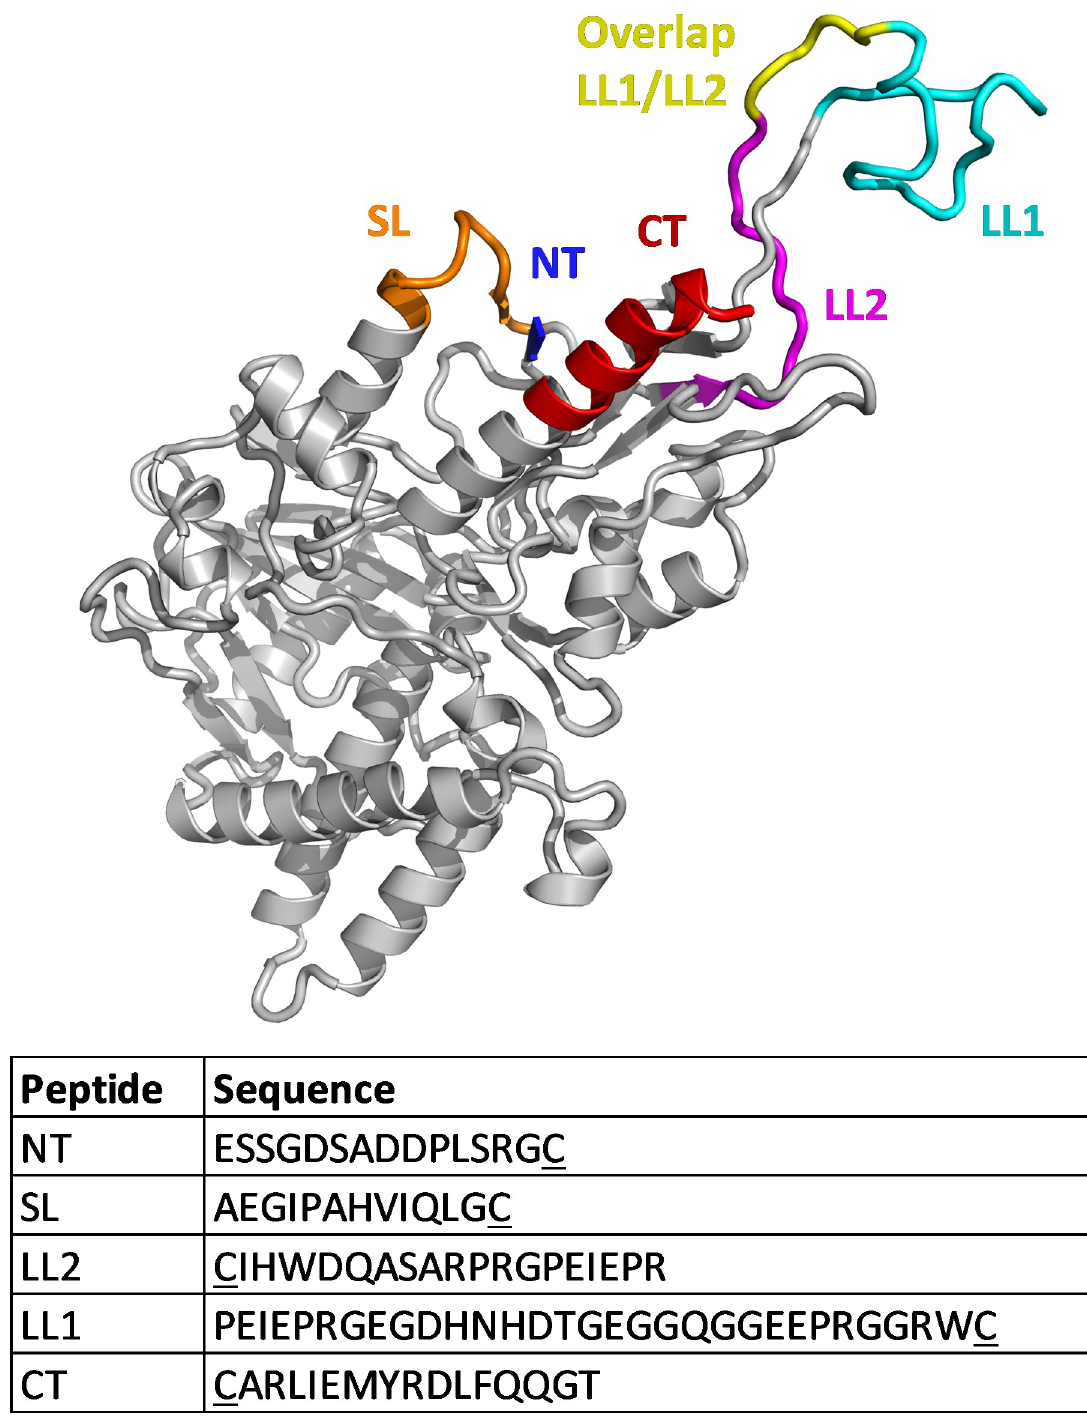
Fig 1. Immunization peptides. Structural model of human SMOX and immunization